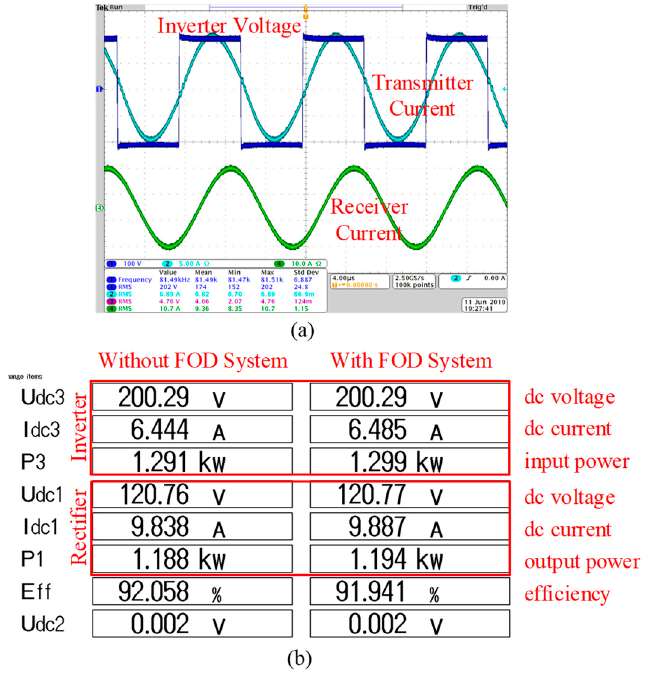
Figure 21. ( a ) Experimental waveforms. ( b ) Snapshot from power analyzer.